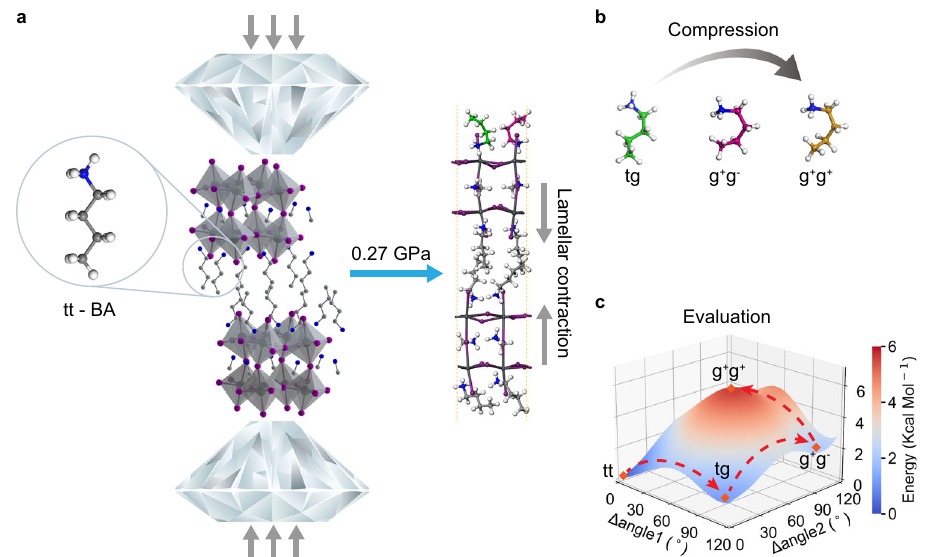
Fig.1|RotationalisomerismofBAmoleculesduringcompressivestressof n =2 RPP.a Schematicshowing diamond anvilcell and the n =2 RPP crystals with linear tt-BA organic chains. b DFT simulation of lamellar contraction and the step-wise